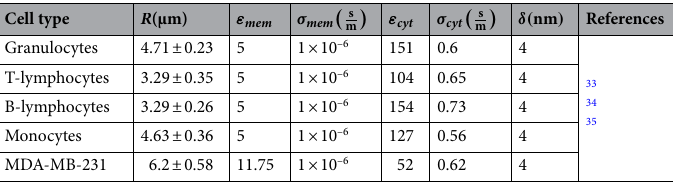
Table 1. Dielectric and mechanical properties of selected cells.